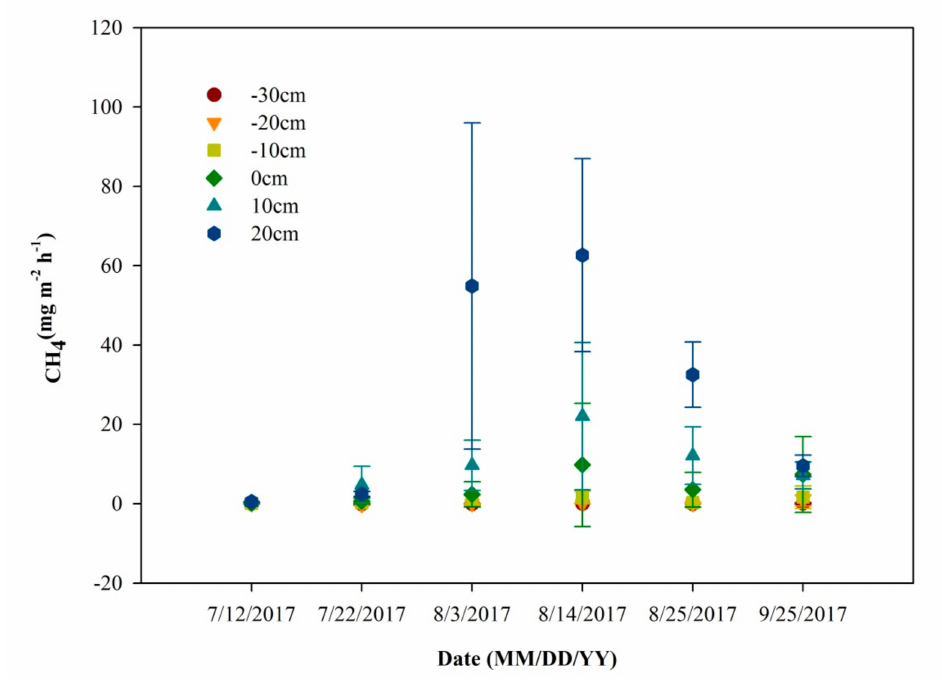
Figure 3. Observations of CH 4 emissions (mean ± SD) at six water table levels (WTLs) at